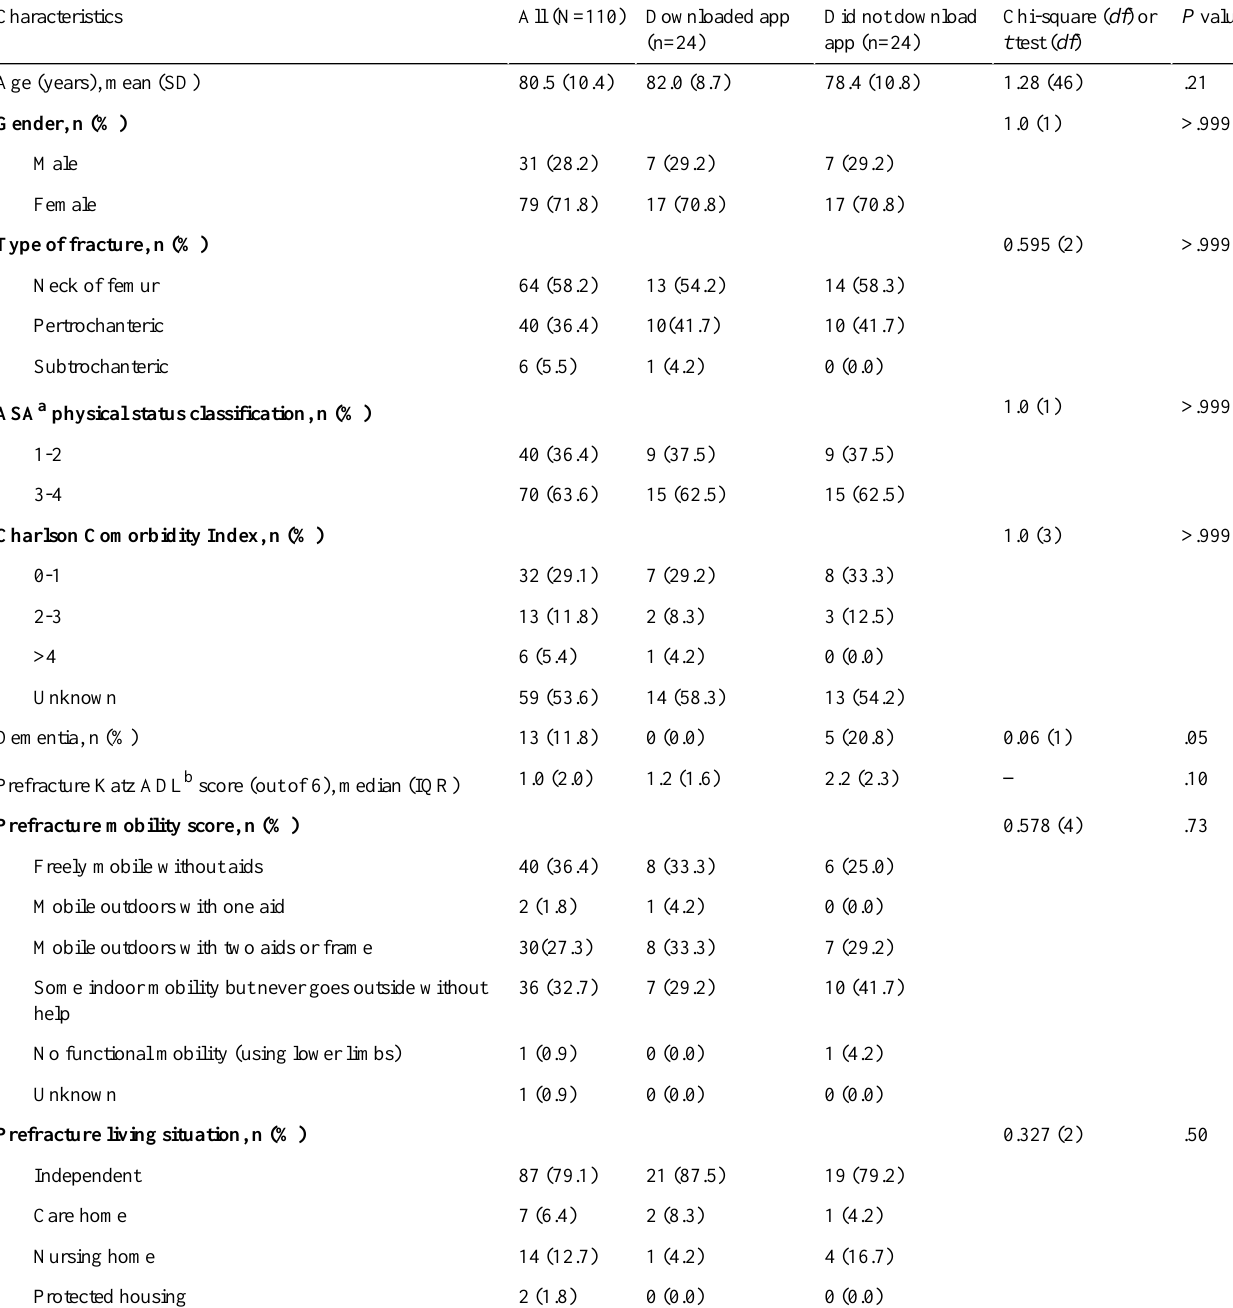
Table 1. Baseline patient characteristics.